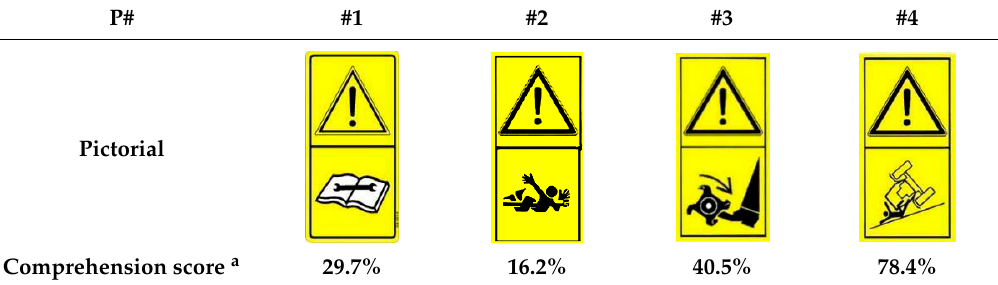
Table 1. Safety pictorials and their meanings (from ISO 11684:1995).